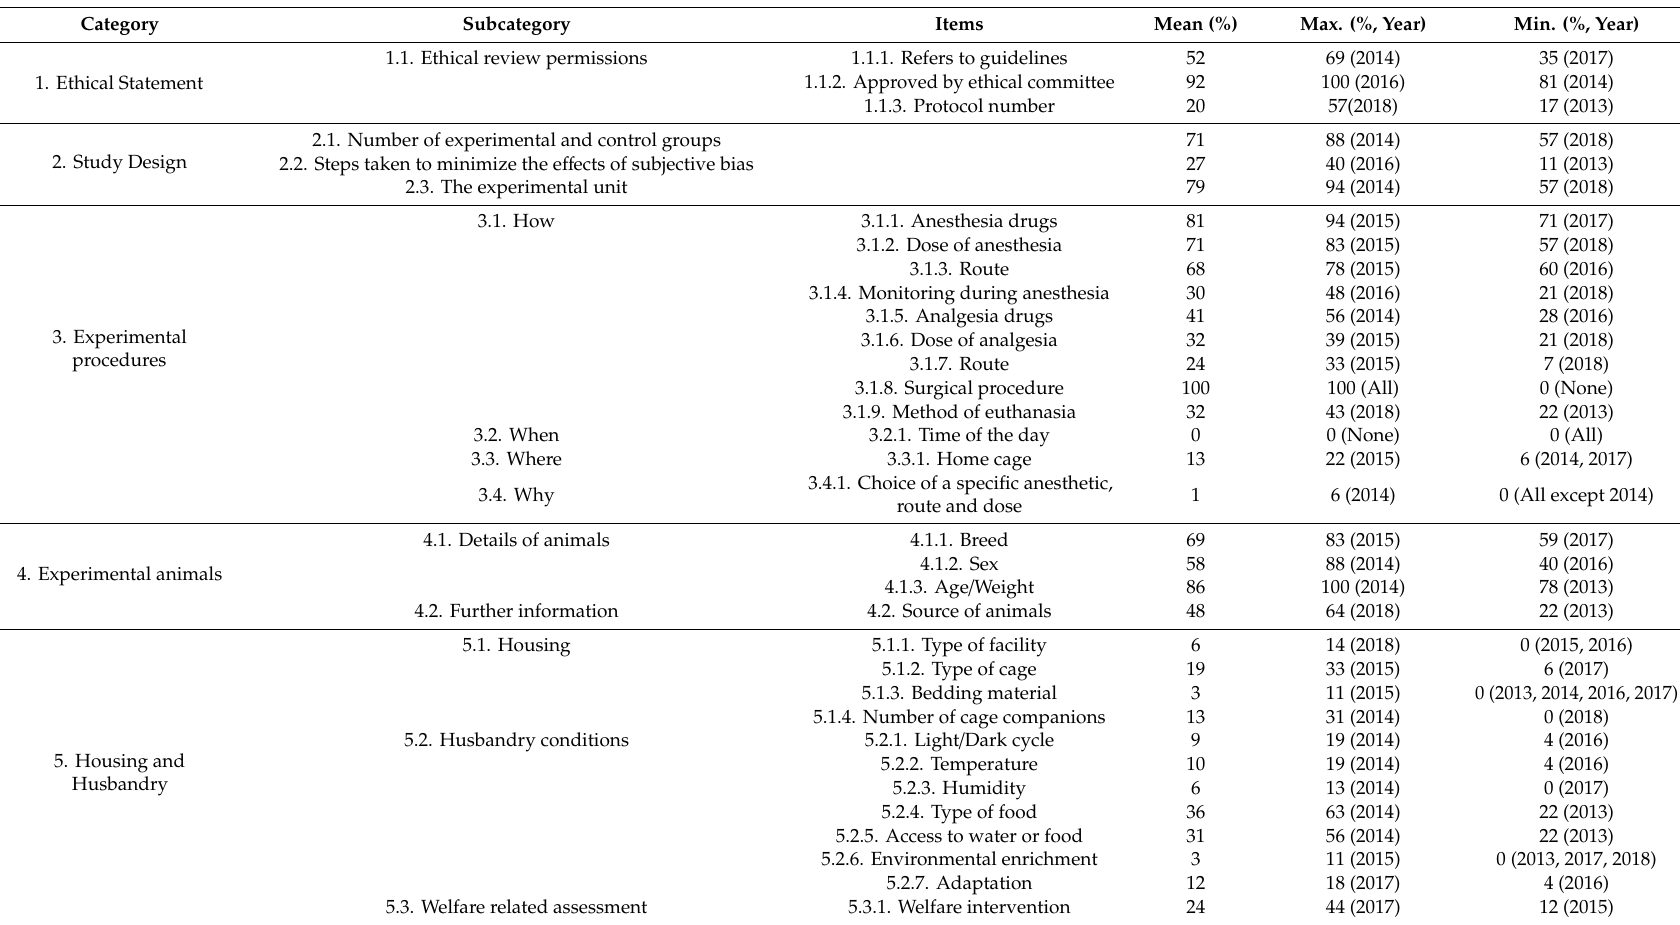
Table 2. Information obtained from the revision of categories, subcategories, and evaluated items, based on the ARRIVE guidelines.